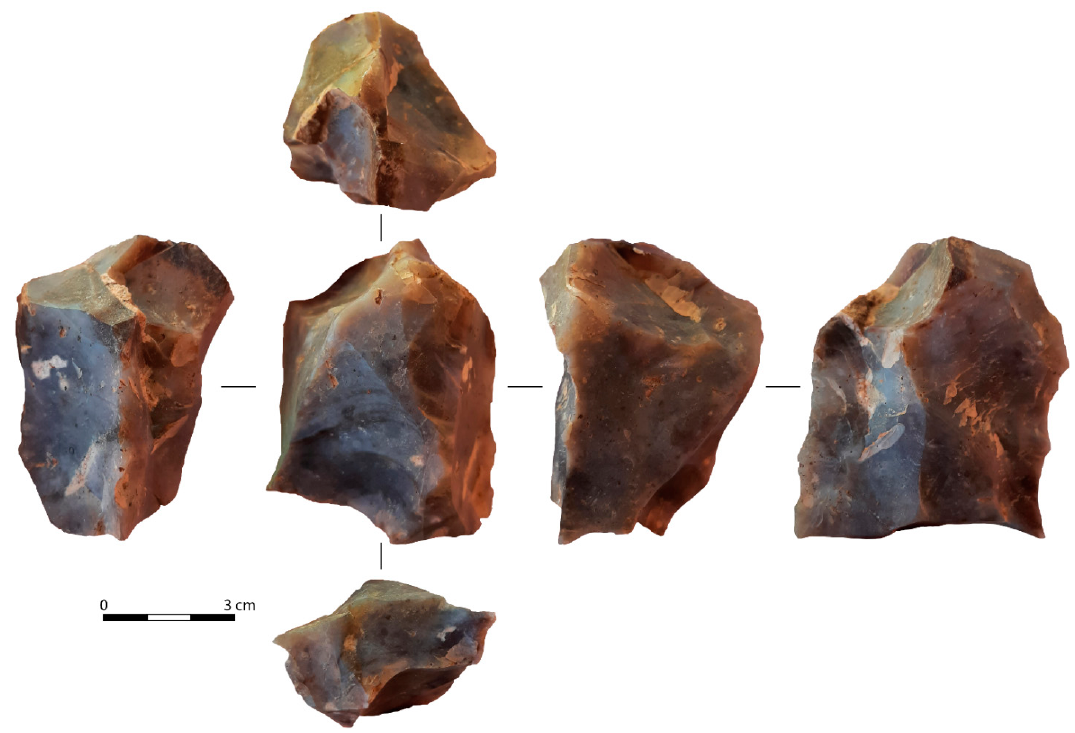
Figure 11. Lojanik 3, preform of blade core from